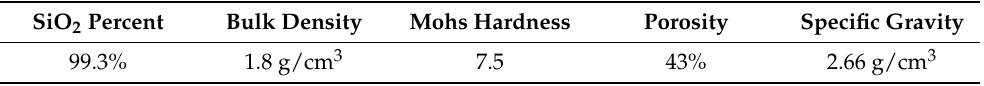
Table 3. Technical indicators of quartz sand.